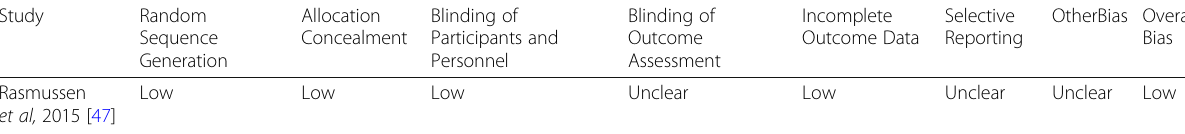
Table 2 Methodological assessment according to the Cochrane Risk of Bias Tool for RCTs Study Random Allocation Blinding of Sequence Concealment Participants Generation